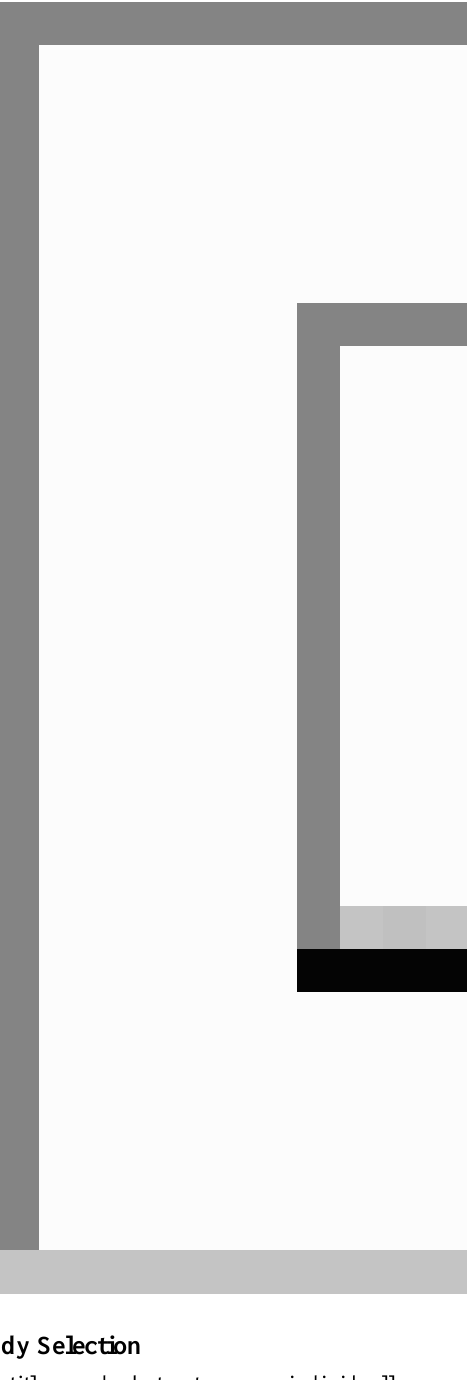
Figure 1. Article selection